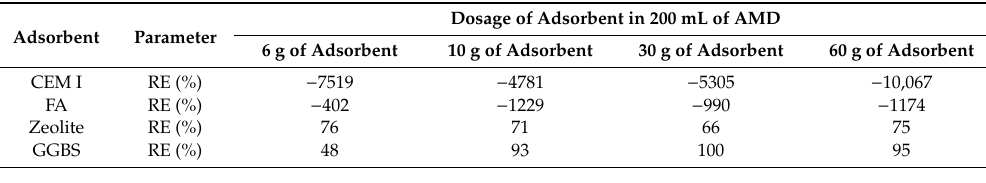
Table 2. Removal E ffi ciency (RE) levels for Cr(VI) removal by Portland cement, fly ash, natural zeolite